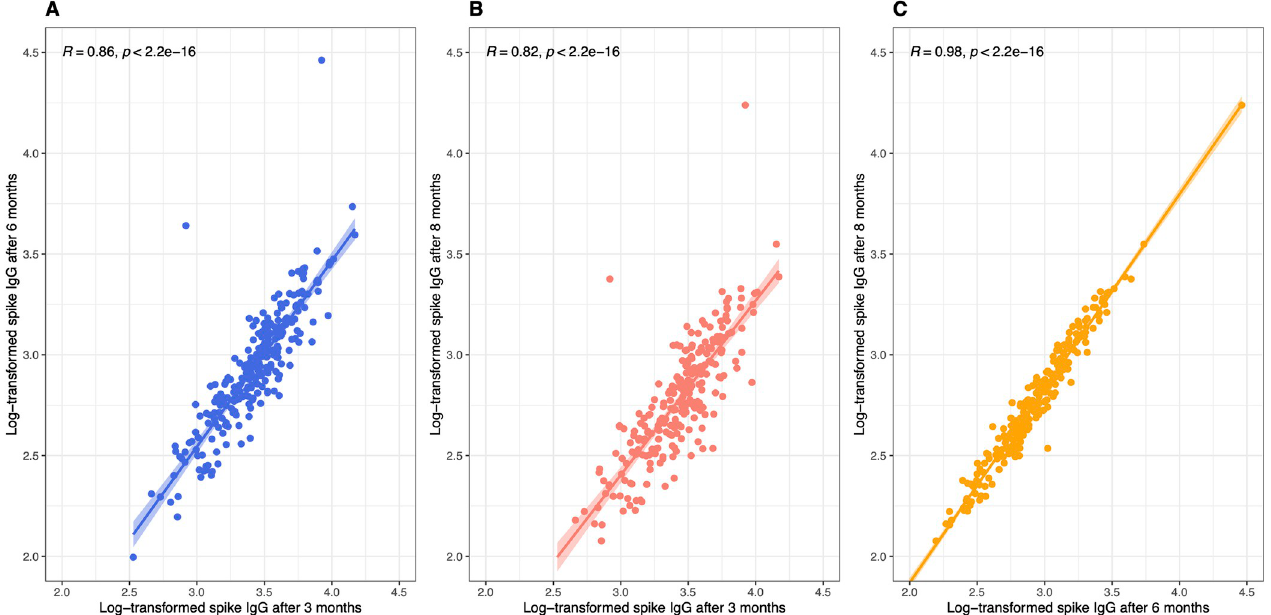
Fig 2. A linear correlation between spike IgG levels at 3 months and 6 months (panel A), at 8 months (panel B), and at 6 months and 8 months (panel C).